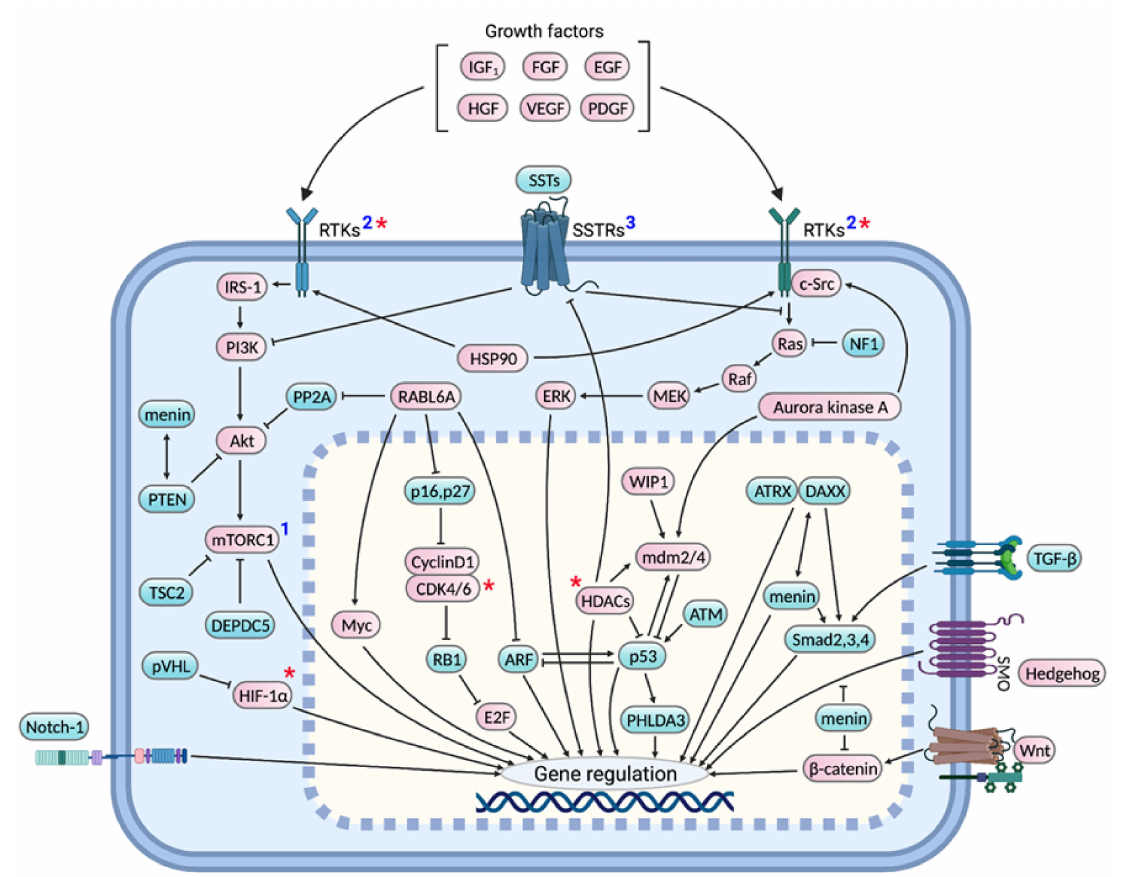
Figure 1. Diagrammatic illustration of important signaling proteins and pathways that drive pNET cell survival, prolifer- ation, angiogenesis, and metastasis. Proteins having oncogenic roles in pNETs are shown in pink boxes whereas pNET suppressors are shown in green. Numbers highlighted in blue indicate FDA approved drugs for therapy that target the corresponding proteins: 1-everolimus, 2-sunitinib, and 3-somatostatin analogues. Asterisks in red denote additional targets being evaluated for pNET therapy. Arrows, activating events; perpendicular bars, inhibitory events. Schematic developed using BioRender software (Toronto,